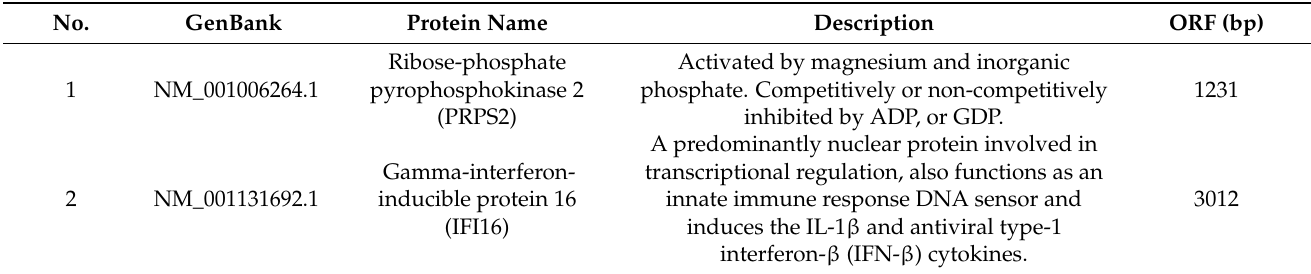
Table 2. The positive proteins used for yeast two-hybrid